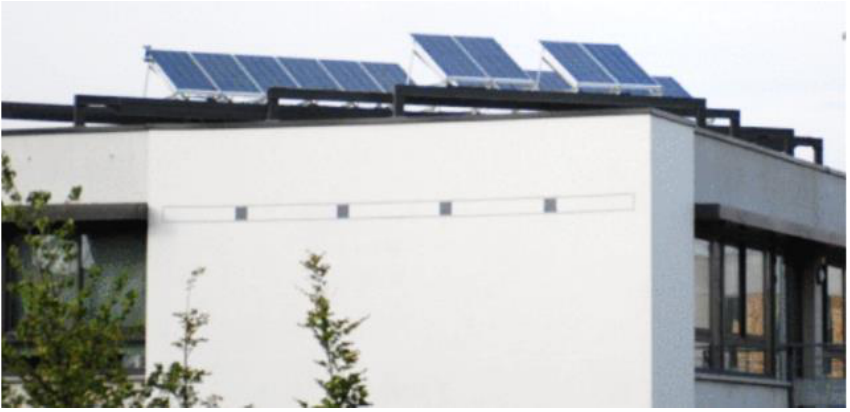
Figure 6. Photovoltaic installation of the Centre Pierre Guillaumat of UTC [17].